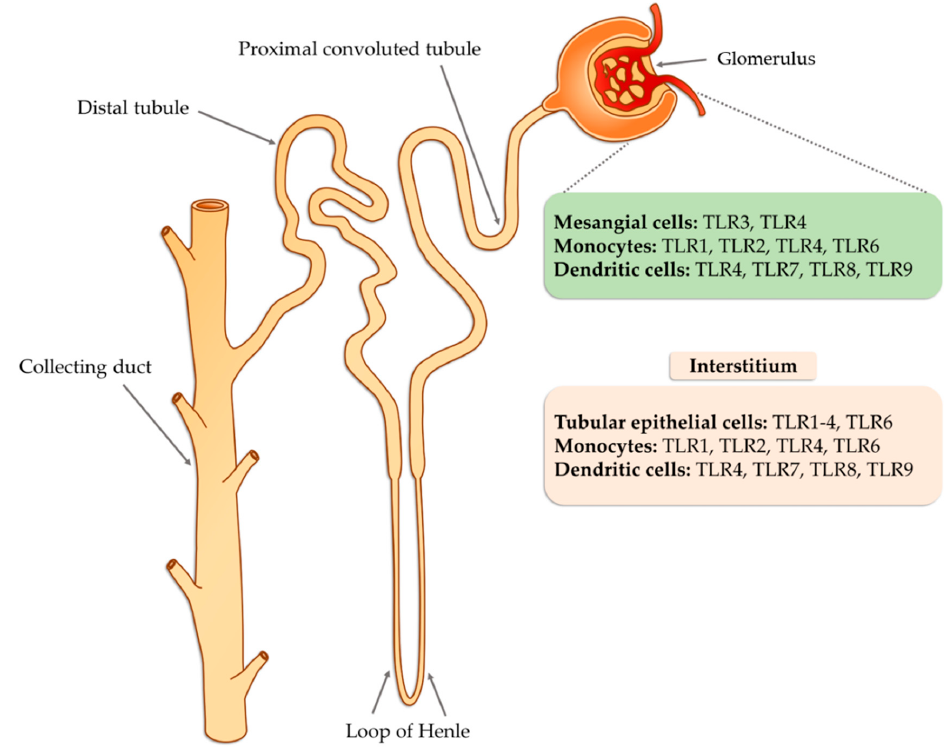
Figure 3. The potential occurrence of TLR receptors within the nephron (modified, based on [63]).